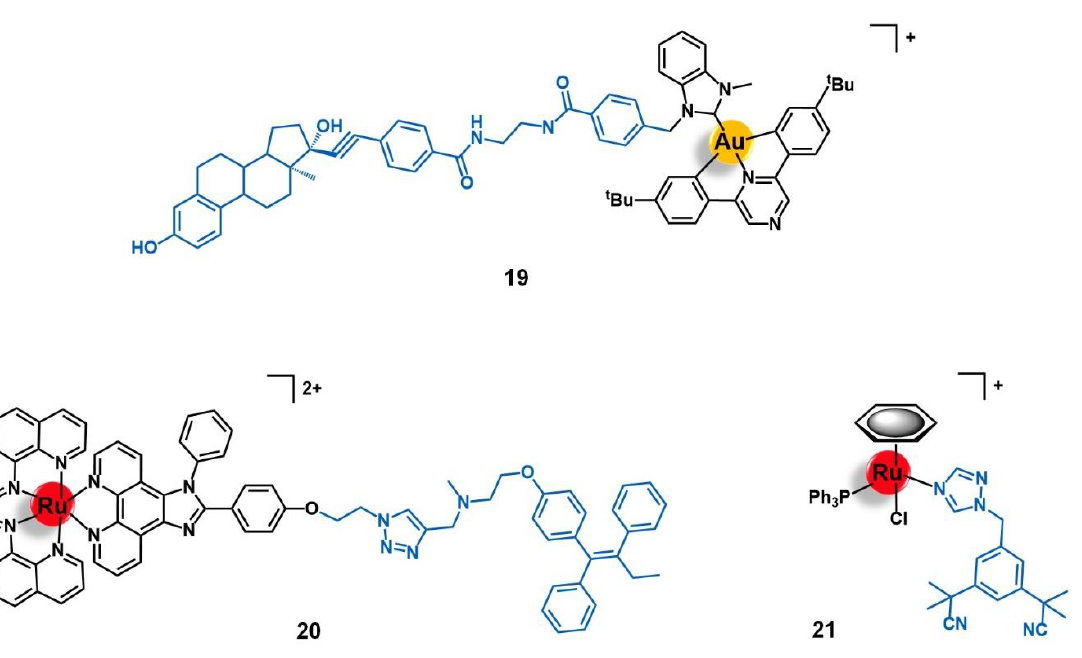
Figure 8. Au(III) and Ru(II) complexes containing an estradiol-derivative ( 19 ), tamoxifen ( 20 ), or anastrozole ( 21 ) for the targeting of the protein-coupled estrogen receptor (GPER). Note: t Bu = tert -butyl.